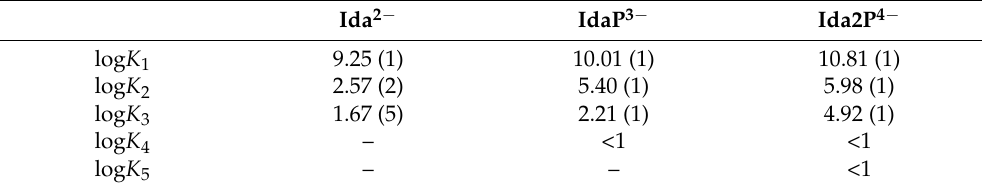
Table 1. Stepwise protonation constants (log K i ) of the ligands at 25.0 °C, I = 0.20 M KCl *.